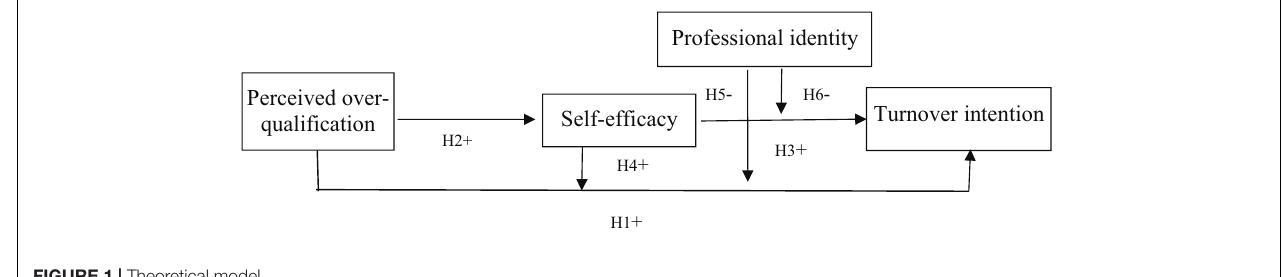
FIGURE 1 | Theoretical model.